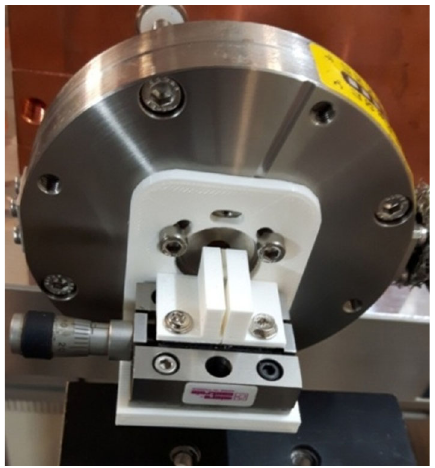
FIG. 18. LiF crystal positioning system for beam energy measurement at the SCTDL-4 output.